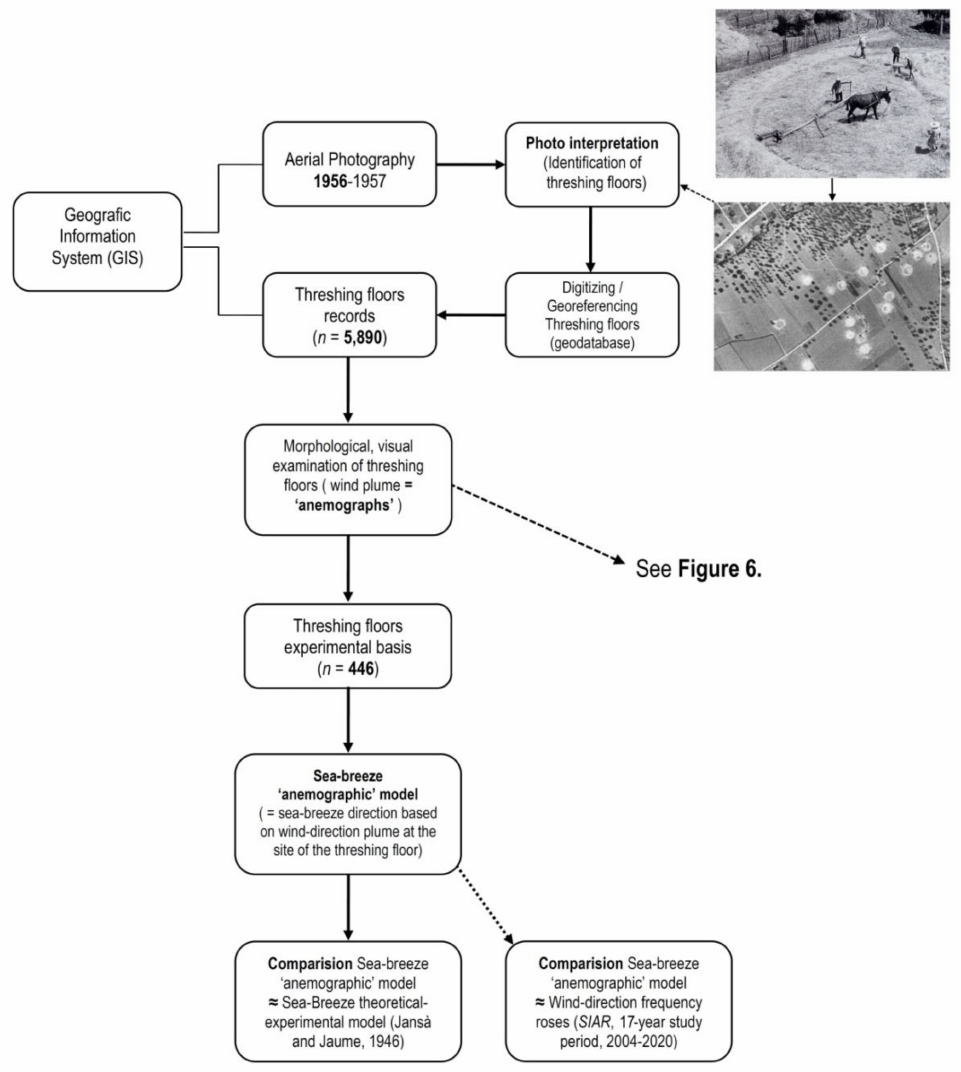
Figure 3. Schematic process flow diagram to identify threshing floors using 1956 aerial photog- raphy, use them as a wind indicator and compare the results with the sea-breeze model of Jans á and Jaume [34], and wind-direction frequency roses for five stations (instrumental data), using a Geographic Information System